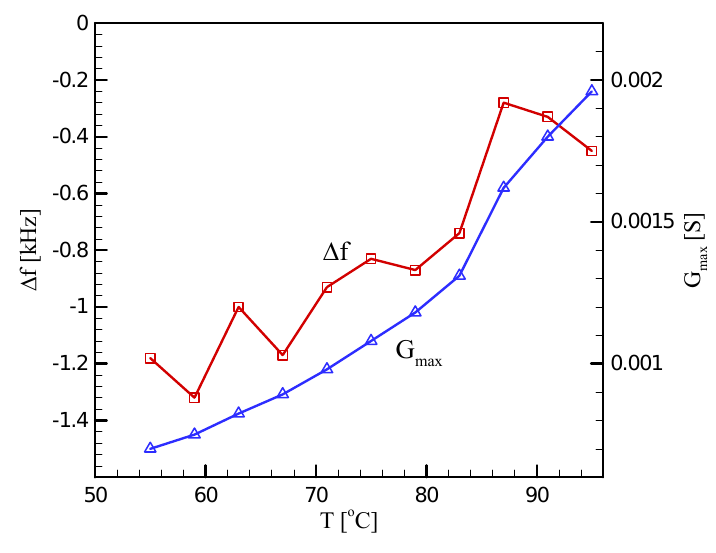
obtained at 11 different max